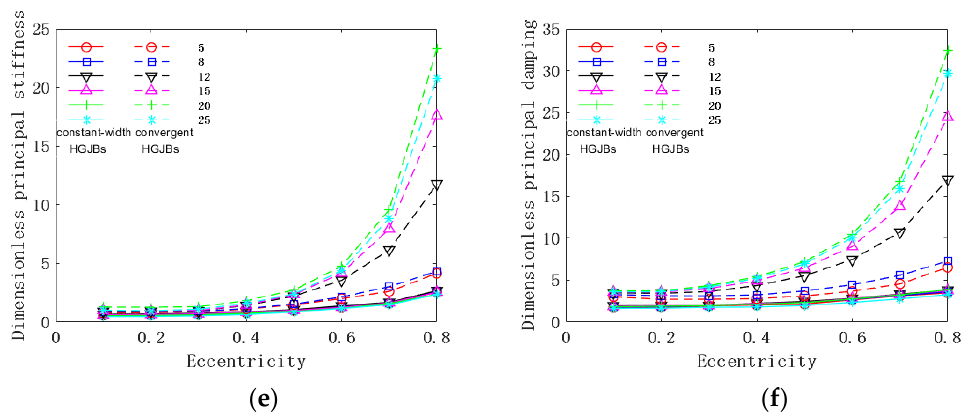
Figure 15. The influence of the number of grooves on the performance of HGJBs: ( a ) Dimensionless load capacity ( b ) Side leakage ( c ) Dimensionless friction power ( d ) Average temperature rise ( e ) Dimensionless principal stiffness ( f ) Dimensionless principal damping.